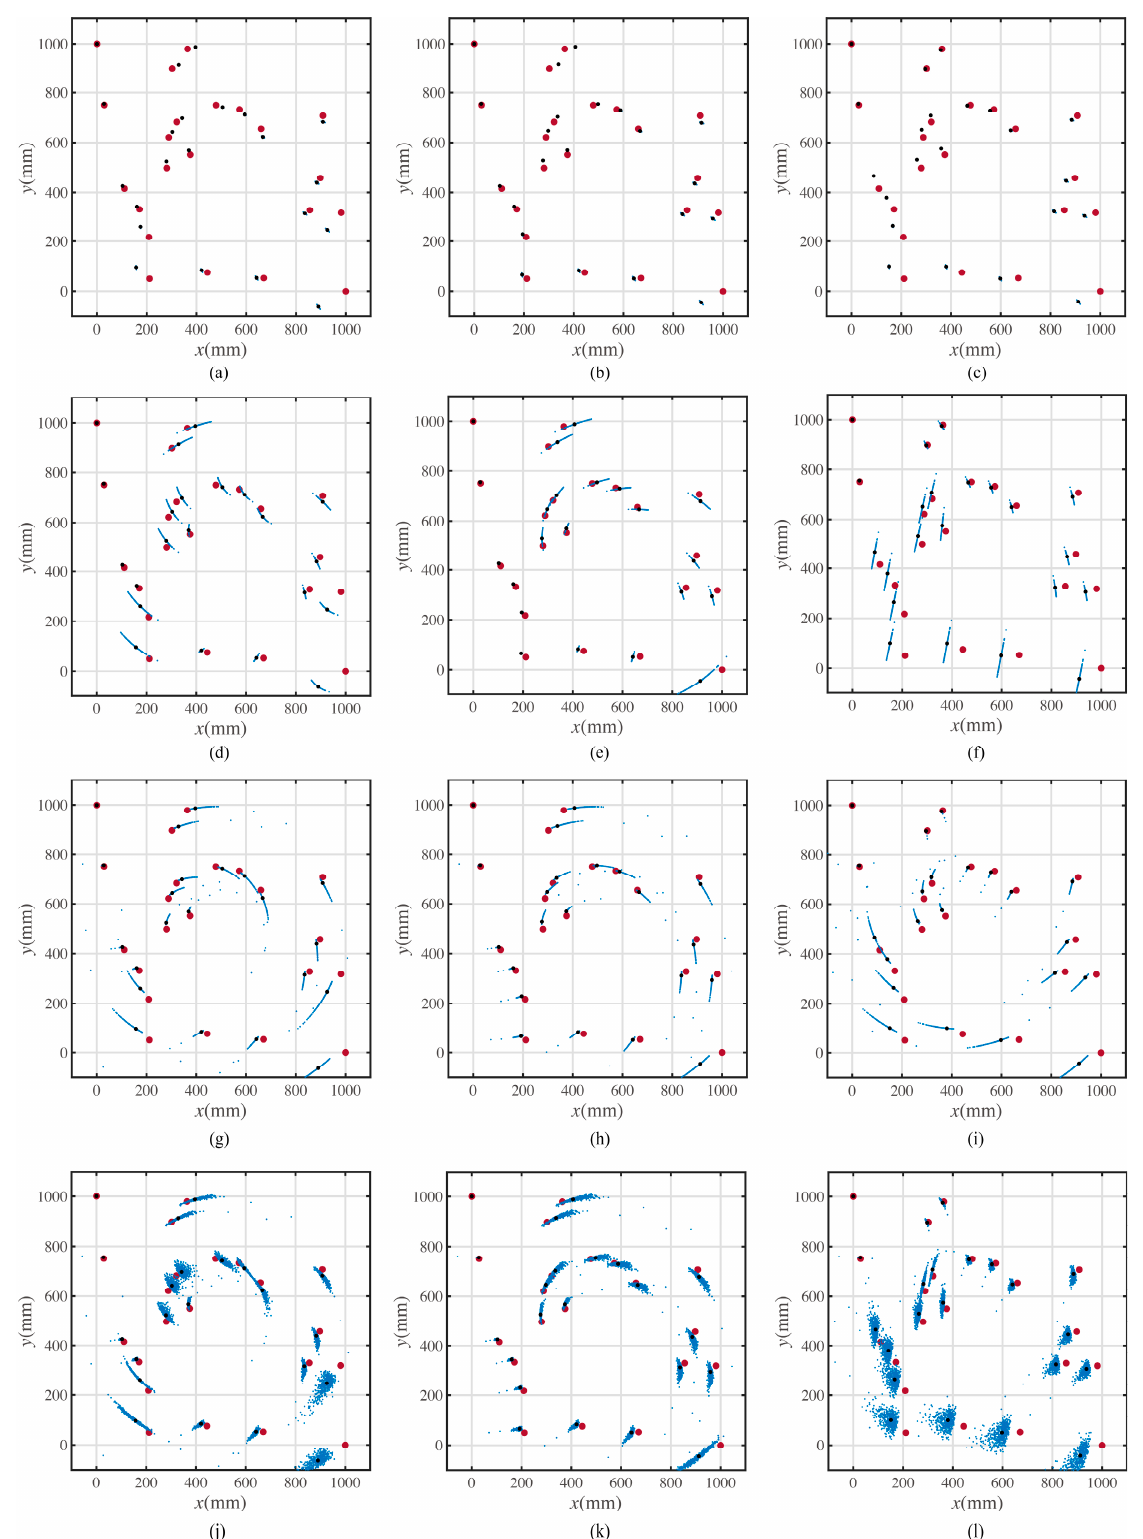
Figure 15. Simulated positions with different path and error parameters. ( a ) The simulated positions for mobile robot moving along the minimum rotation angle path with considering the forward moving error coefficient as a random variable. ( b ) The simulated positions for mobile robot moving along the minimum average position error path with considering the forward moving error coefficient as a random variable. ( c ) The simulated positions for mobile robot moving along the minimum forward moving distance path with considering the forward moving error coefficient as